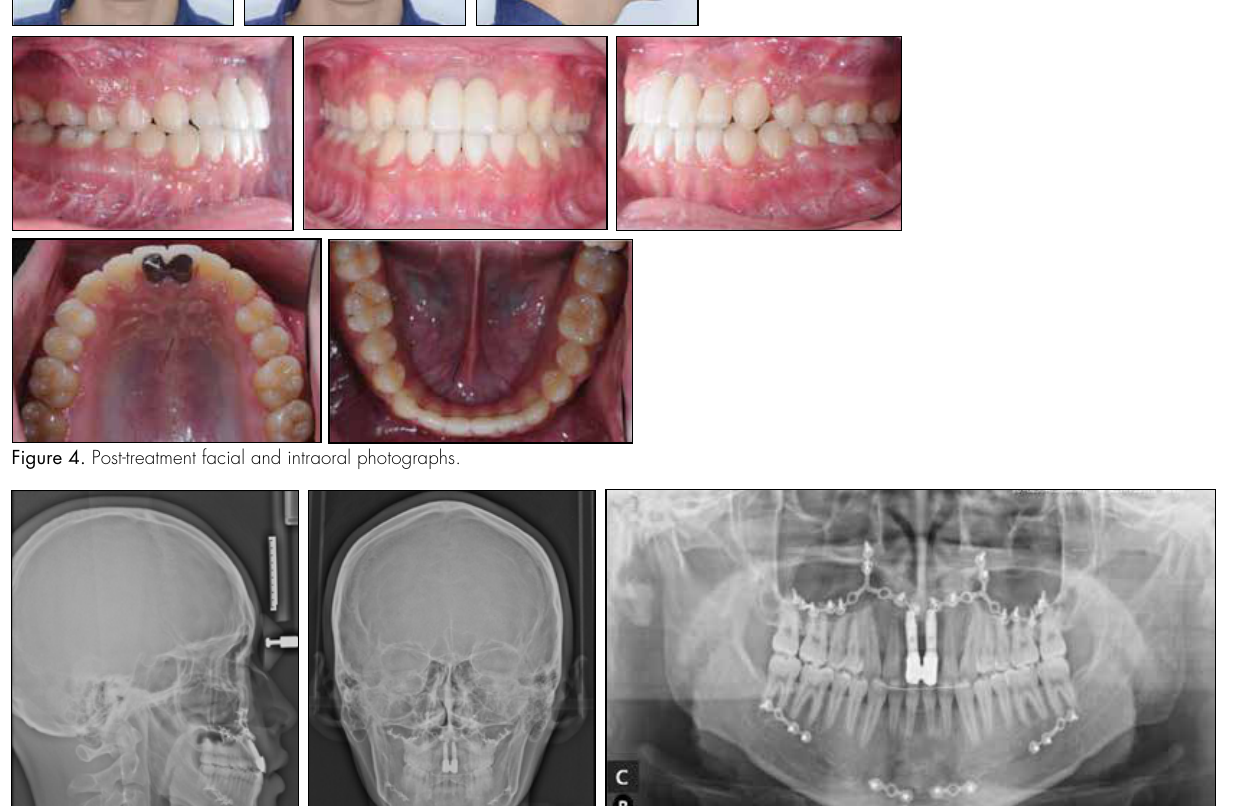
Figure 5. Post-treatment radiographs. A, lateral cephalogram; B, posterio-anterior cephalogram; C, panoramic radiograph.